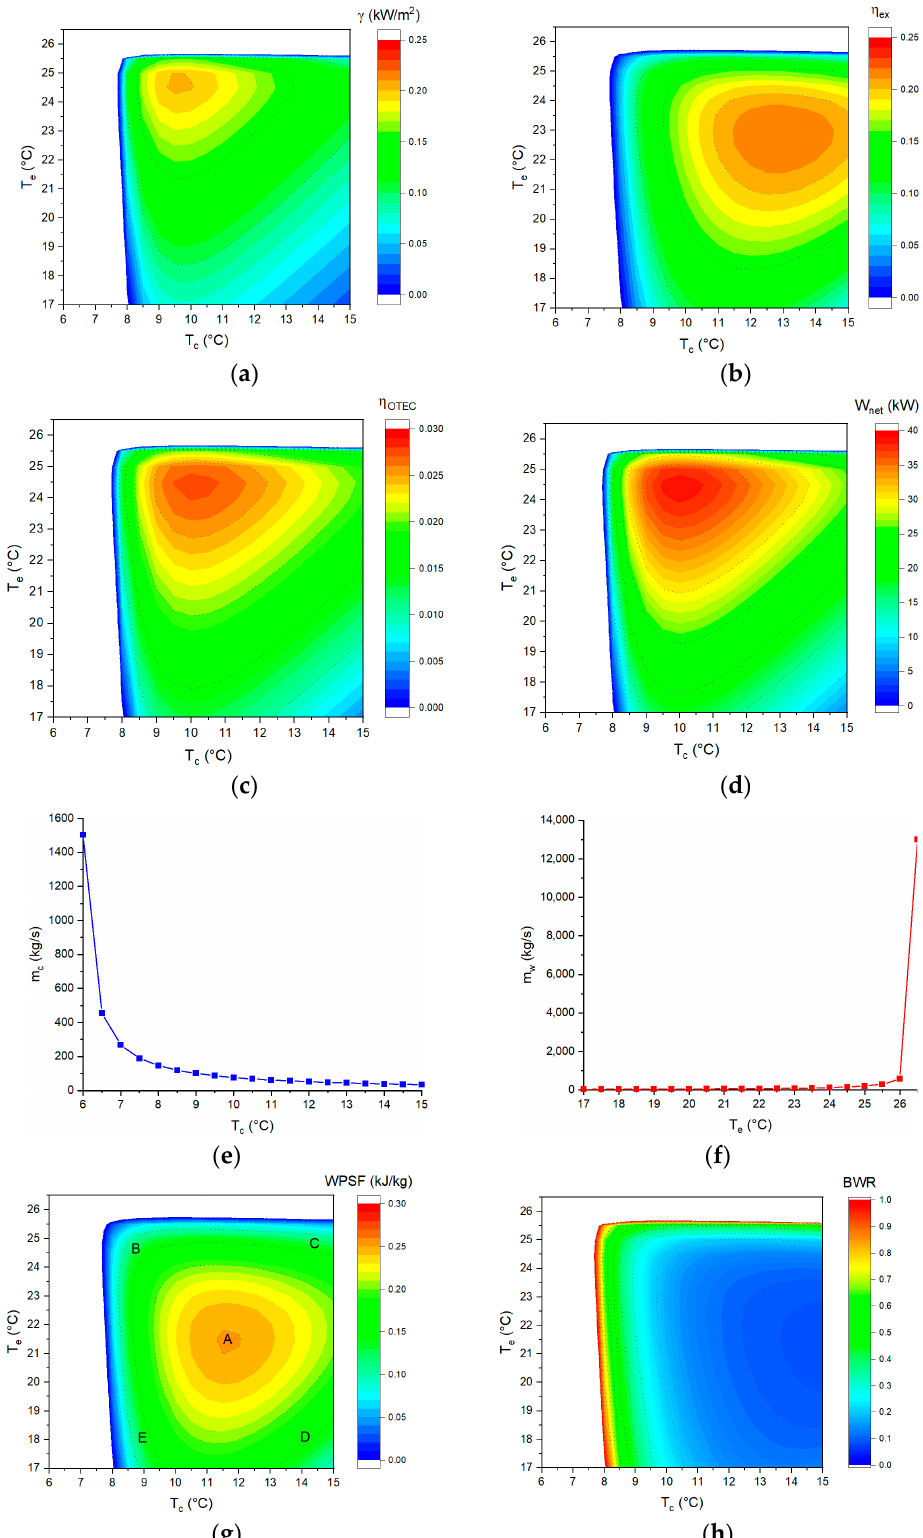
Figure 9. The effect of evaporating temperature and condensing temperature on ( a ) the net output power per unit area, ( b ) the exergy efficiency, ( c ) the thermal efficiency of OTEC, ( d ) the net output power, ( e ) the deep seawater flow rate, ( f ) the surface seawater flow rate, ( g ) the net output power per unit seawater flow rate, and ( h ) the back work ratio.